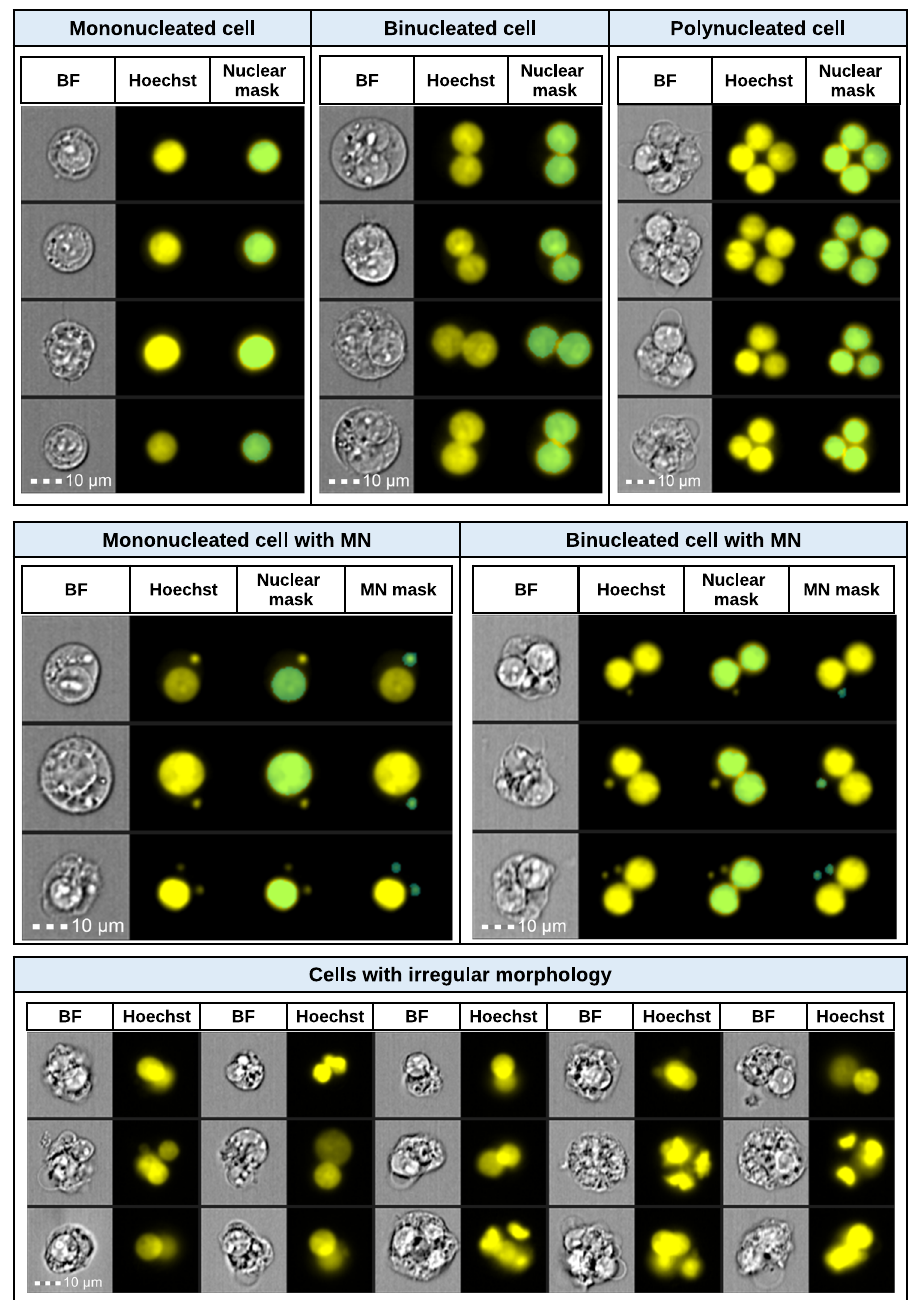
Fig. 1 Representative IFC imagery of all key events that must be scored in the in vitro micronucleus (MN) assay. Key events include mononucleated cells (with and without MN), binucleated cells (with and without MN), and polynucleated cells. Cytoplasmic material is visible in the Bright fi eld imagery and DNA content (e.g. main nuclei and MN) is visualized in the Hoechst (yellow) channel. Masks (cyan) overlaid onto the images identify either the main nuclei or the MN. Representative imagery of events with irregular nuclear morphology that do not fi t the published scoring criteria are also map permitting rapid addition into the ground truth data. model using the features extracted from the pre-trained CNN. The Conversely, for example, the morphological differences between predicted classes created match the classes in the ground truth BN cells with and without MN are very subtle and as such, the two data and objects that do not fi t well into any class are labeled as populations are essentially mixed on the object map. However, unknown. In this work, Fig. 2b demonstrates that the predict the user can view all imagery in the predicted classes for both algorithm creates six model classes and plots them on the object populations which makes rapid population of the ground truth map: MONO (red), MONO with MN (yellow), BN (blue), BN with MN datasets achievable because objects are pre-sorted into the (purple), POLY (green) and irregular (cyan). The morphological highest probability class. This functionality is especially useful for differences between the MONO and POLY class are readily identifying rare objects which are laborious to identify in a non- identi fi ed, hence their positioning at opposite ends of the object